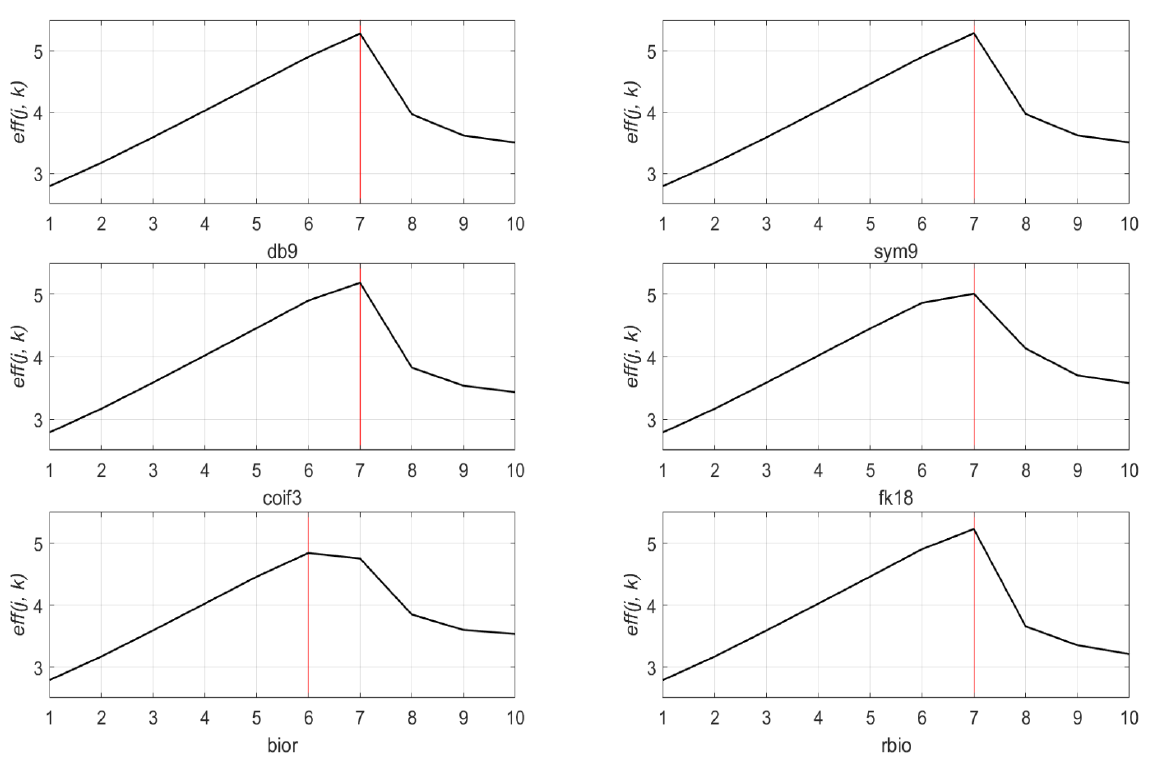
Figure 9. 𝑒𝑓𝑓(𝑗,𝑘) values of 10 decomposition levels (1 to 10) for six mother wavelet functions (db9, sym9, coif3, fk18, bior, and rbio).